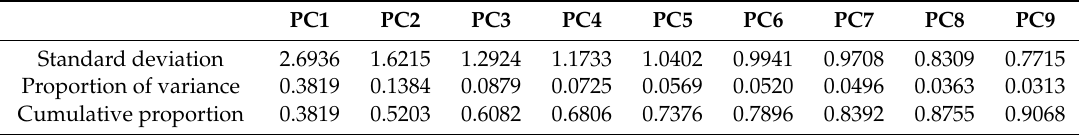
Table 4. Principal Component Analysis (PCA) Summary—the first nine principal components